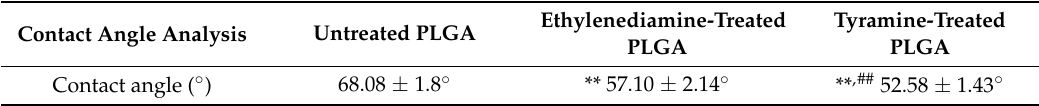
Figure 3. Water contact angle and results of surface analysis by X-ray photoelectron spectroscopy (XPS) of untreated and surface-treated PLGA scaffolds. ( A,D ) Untreated scaffolds. ( B,E ) Ethylenediamine (ED)-treated scaffolds. ( C,F ) Tyramine-treated scaffolds. Table 2. Water contact angle of surface-treated bilayered PLGA scaffolds. Values represent mean ± SD ( n = 8). ** p < 0.01 versus the untreated PLGA group; ## p < 0.01: ED-treated group versus the tyramine-treated group.